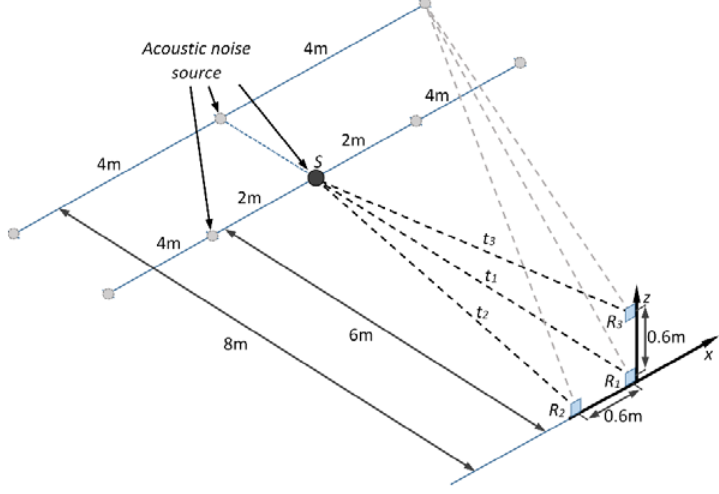
Figure 8. The graphical illustration of the experimental set-up used for detectability. Table 3. The coordinates of the source S used in the experiments with set-up I and set-up II. Position